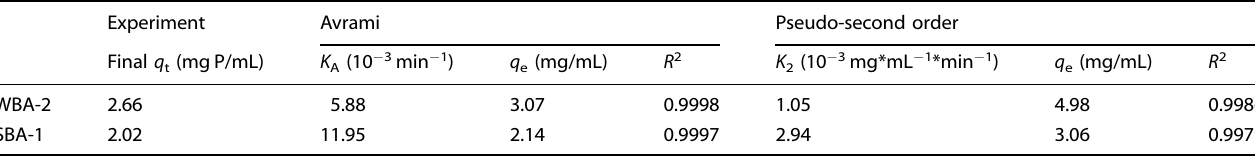
Table 2. Kinetic parameters for Avrami and pseudo-second order models.